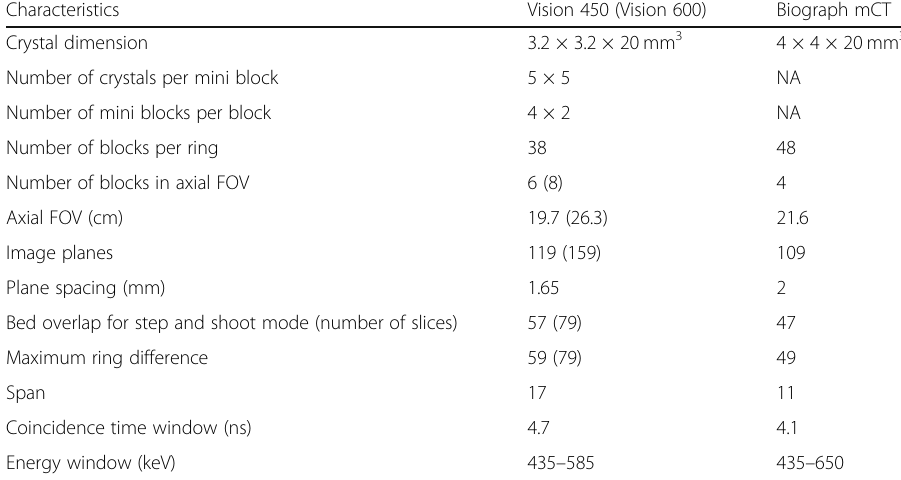
Table 1 Technical specifications of the PET component for Vision 450 (Vision 600 within